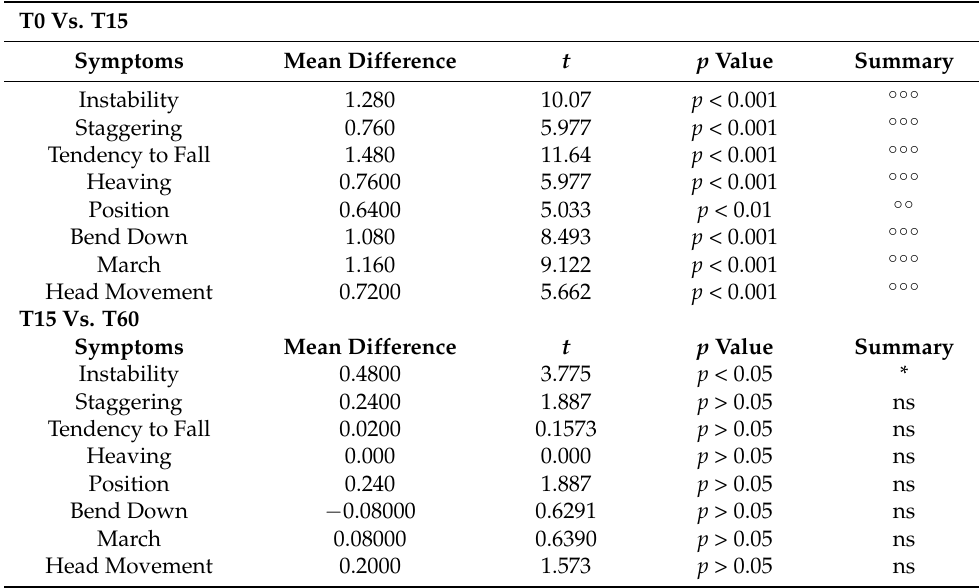
Table 4. Statistical analysis obtained using a Bonferroni post-hoc test on the factors triggering the onset of vertigo. T0 Vs. T15